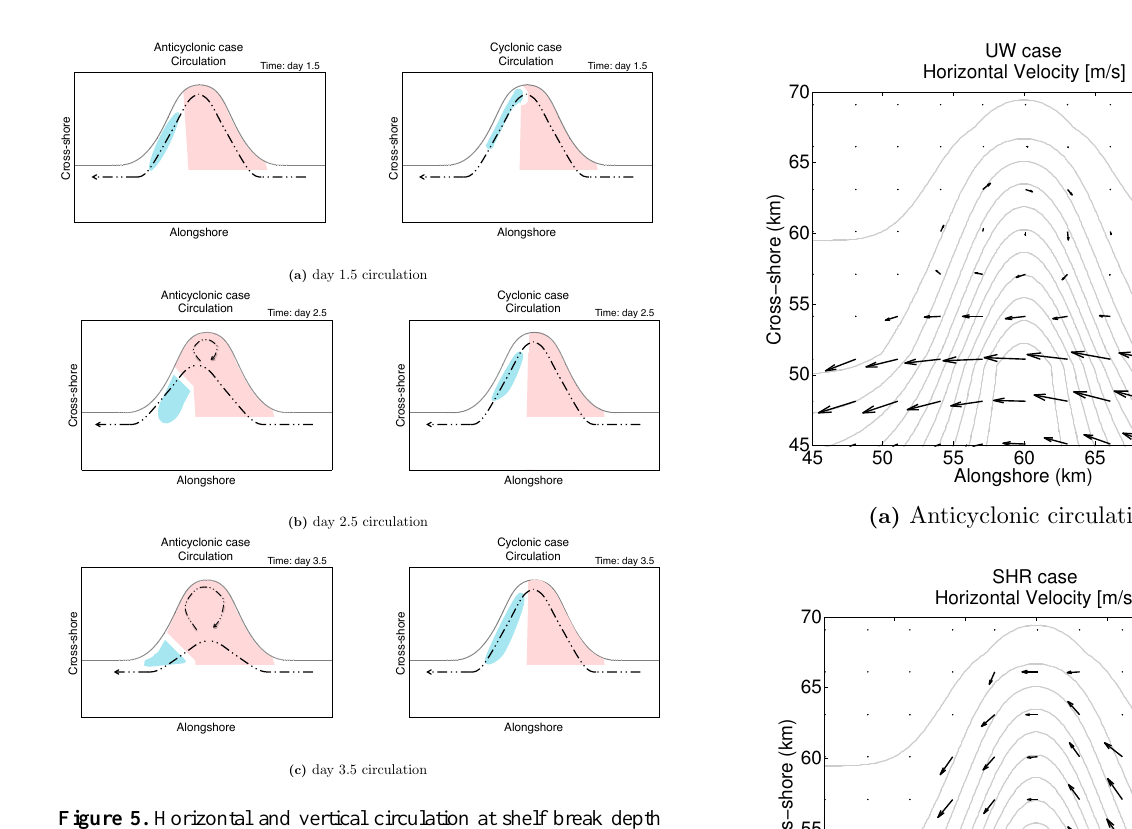
Figure 5. Horizontal and vertical circulation at shelf break depth during the time-dependent phase on (a) day 1.5, (b) day 2.5, and (c) day 3.5. Pink shading indicates downwards velocity and blue shading indicates upwards velocity. Circulation for simulations with anticyclonic circulation (left) and cyclonic circulation (right) are shown.